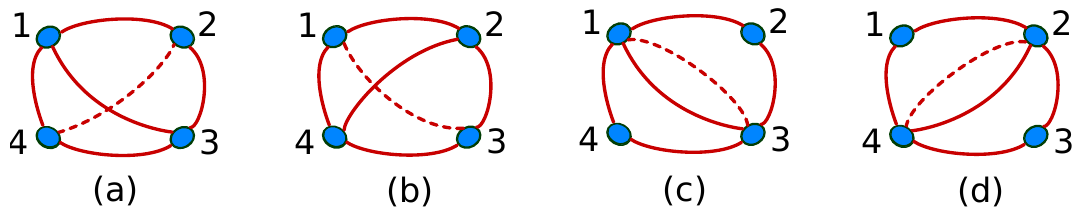
Figure 1 . Planar four-point tree-level diagrams involving single-trace operators. Operators are depicted by a black ring, with crimson lines between operators i; j representing the product of l ij